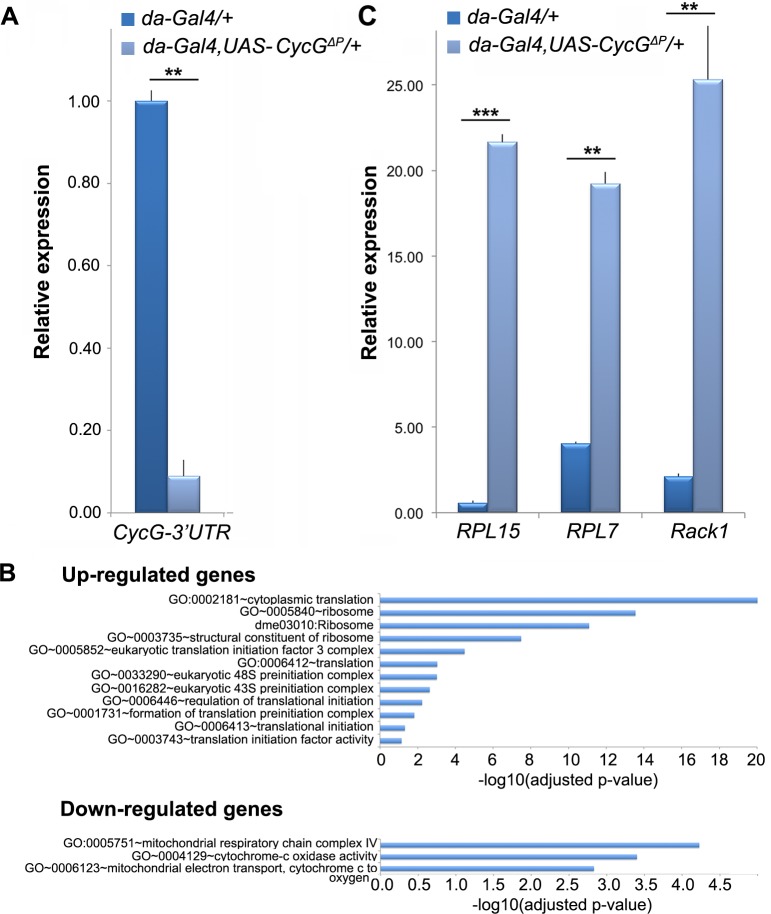
Genes deregulated in wing imaginal discs expressing
CycGΔP.A–RT-qPCR analysis of endogenous CycG
expression in
da-Gal4,UAS-CycGΔP/+
and da-Gal4/+ wing imaginal discs. Expression of
CycG was normalized on the geometric mean of
Lam and rin (S8
Table). t-tests, ** p-value<0.01. Error bars correspond to
standard deviations. B–Ontology of up-regulated and
down-regulated genes in da-Gal4,
UAS-CycGΔP/+ vs
da-Gal4/+ wing imaginal discs. Gene ontology analysis was
performed with DAVID (S9 Table). C–RT-qPCR
analysis of RPL15, RPL7 and
Rack1 expression in da-Gal4,
UAS-CycGΔP/+
and da-Gal4/+ wing imaginal discs. Expression of
RPL15, RPL7 and
Rack1 were normalized on the geometric mean of
Lam and rin (S10
Table). t-tests, ** p-value<0.01. Error bars correspond to
standard deviations. t-tests, ** p-value<0.01; ***
p-value<0.001.